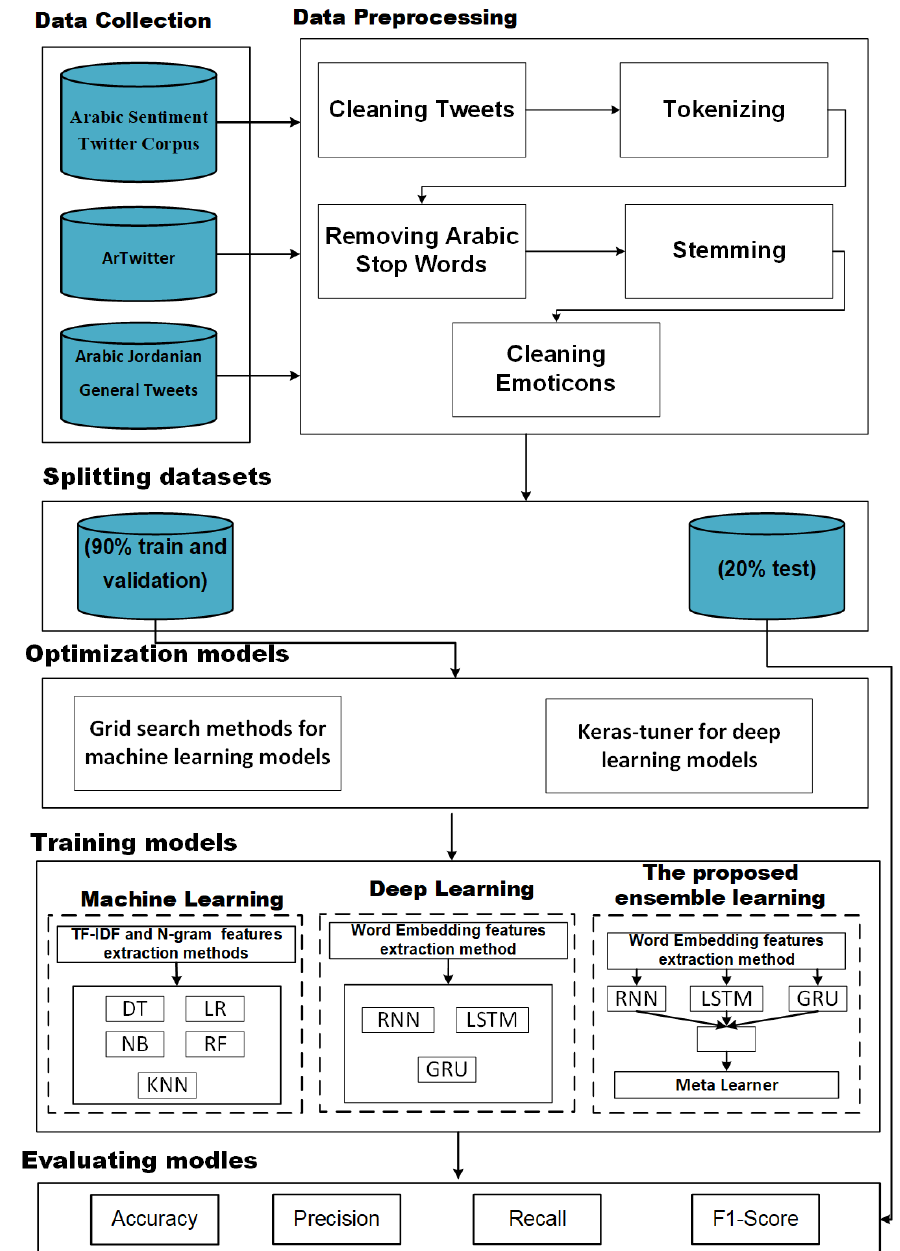
Figure 1. Steps of the predicting sentiment analysis for Arabic